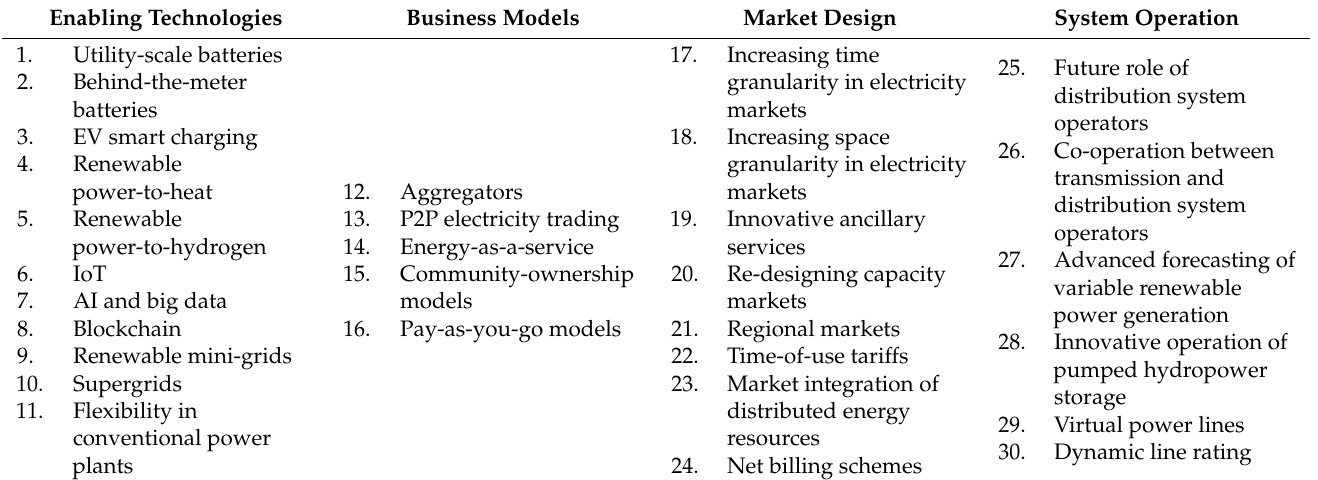
Table 2. The landscape of innovations to integrate variable renewable